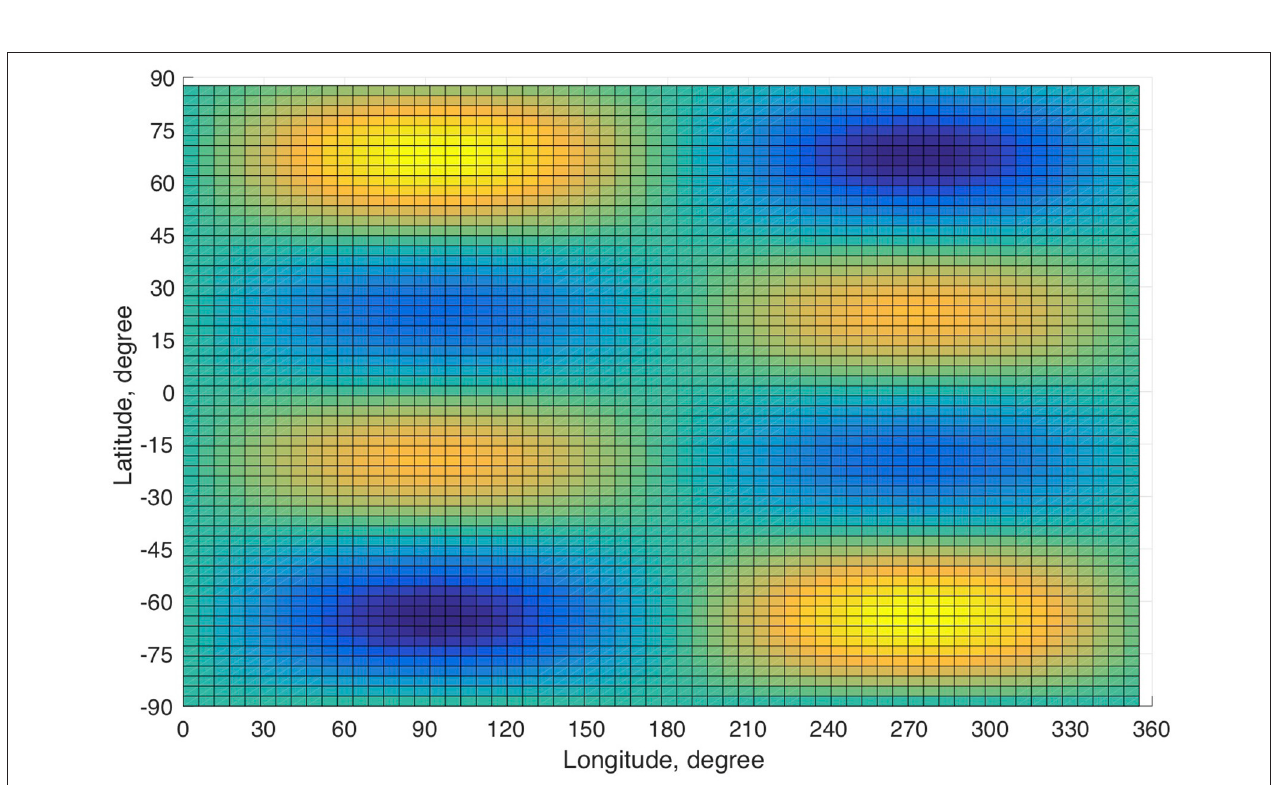
1 and n 3 harmonic is shown. = =